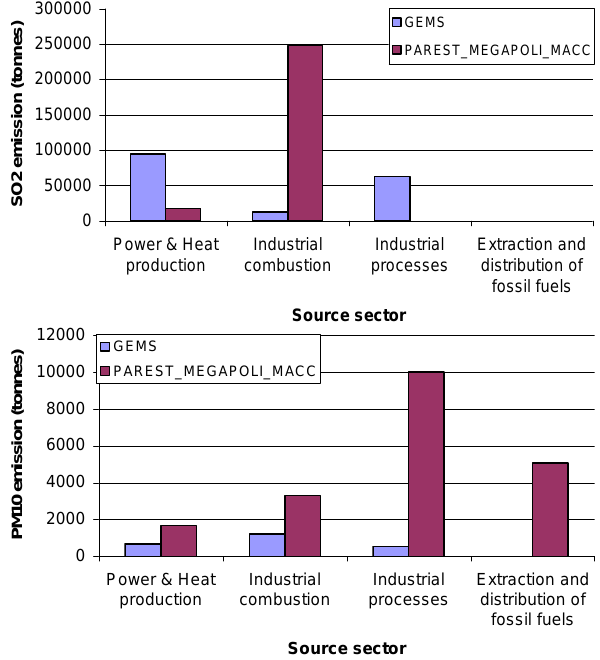
Fig. 4. Emissions of SO 2 (upper panel) and PM 10 (lower panel) for the Kola domain in TNO-GEMS and PAREST-MEGAPOLI databases.